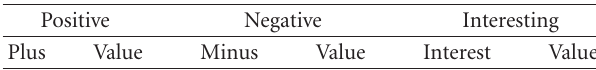
Algorithm 3: Fragment of the estimation results. Table 1: Table structure for PMI